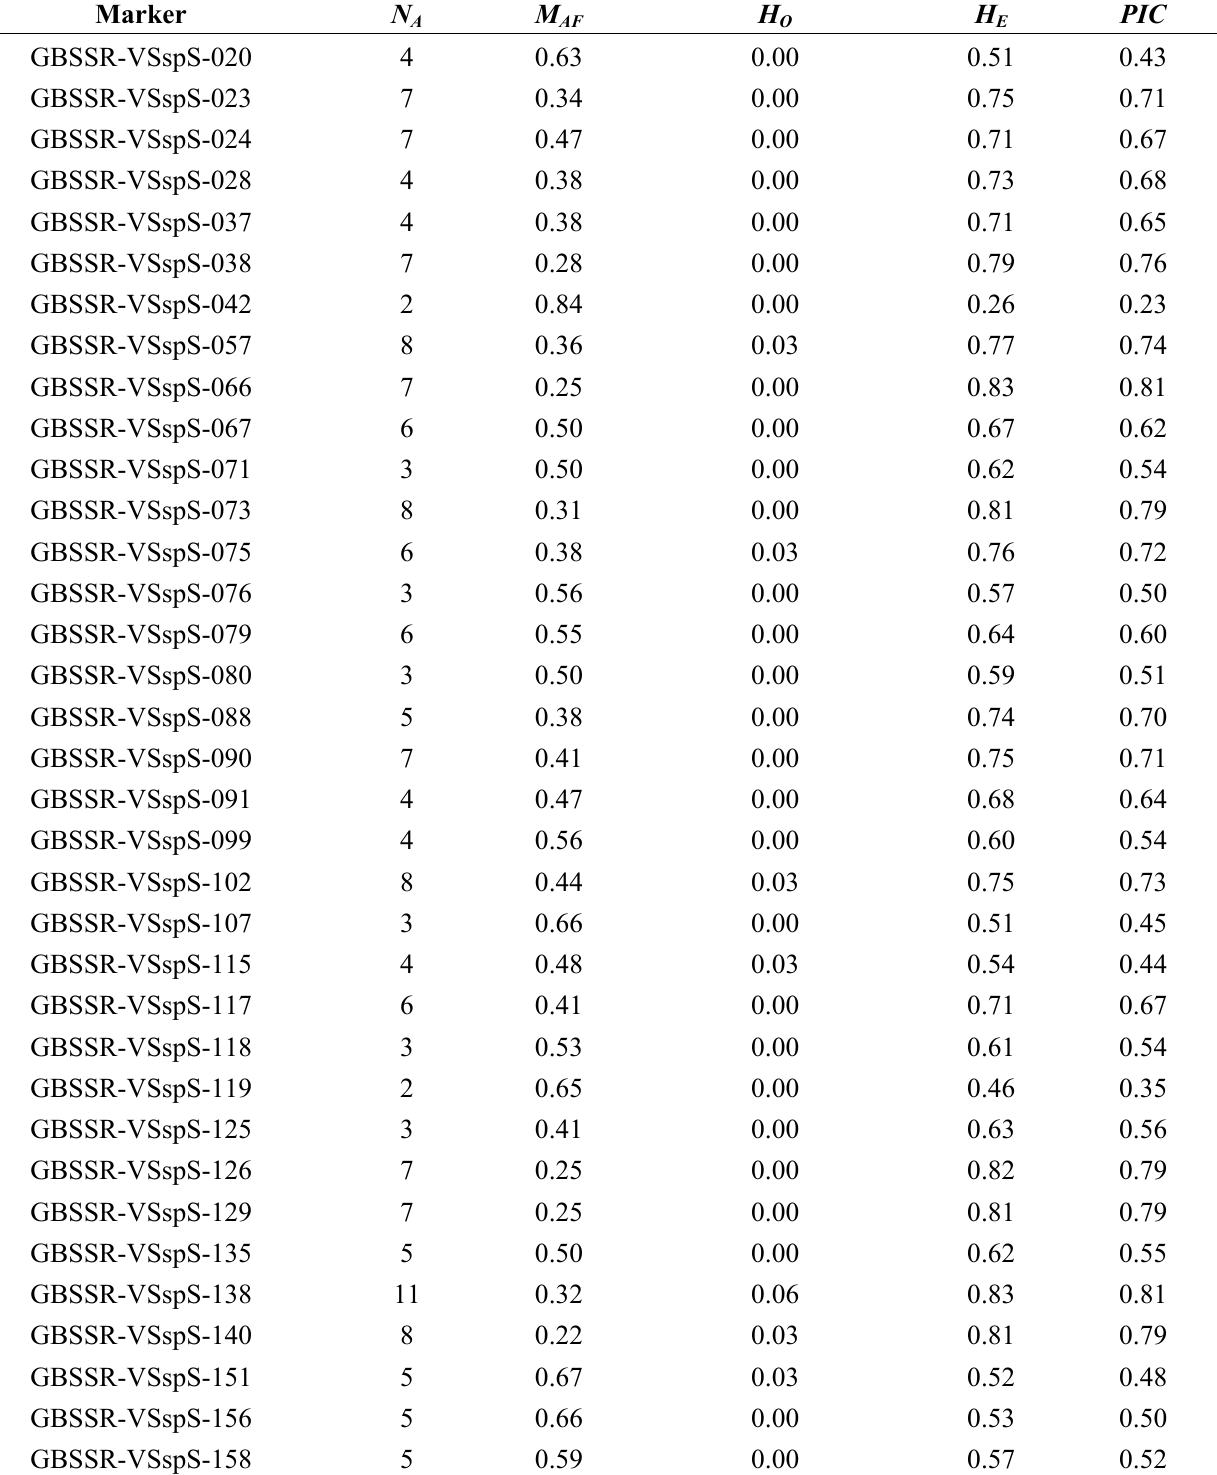
Table 2. Diversity statistics from initial primer screening in 32 accessions of common vetch ( Vicia sativa subsp. sativa